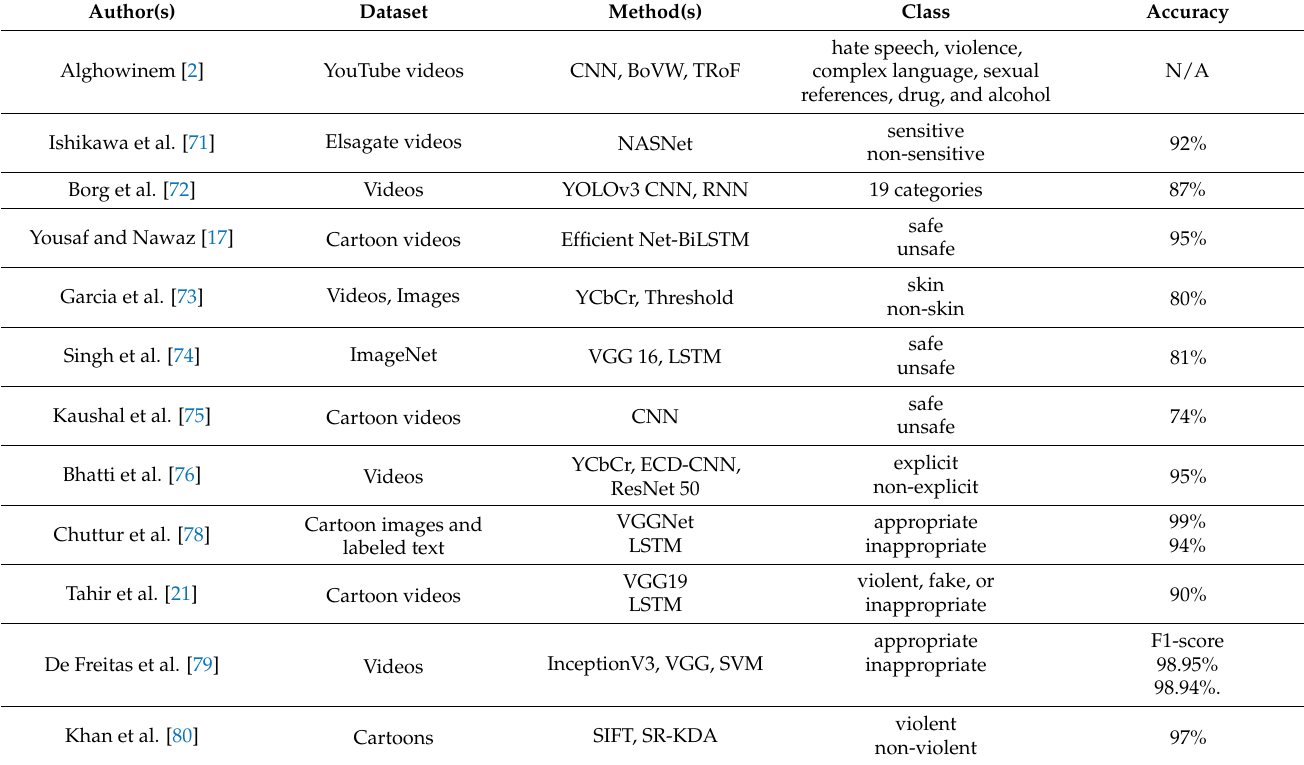
Table 4. Comparative study on video frame